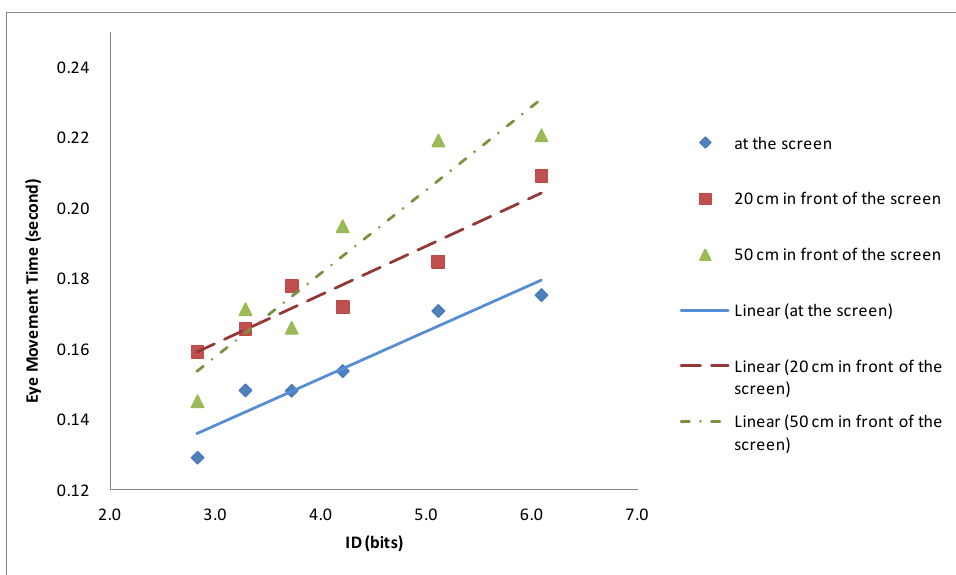
Figure 8 Eye movement time (second) in three parallax levels (at the screen, 20 cm in front of the screen, and 50 cm in front of the screen) plotted against index of difficulty